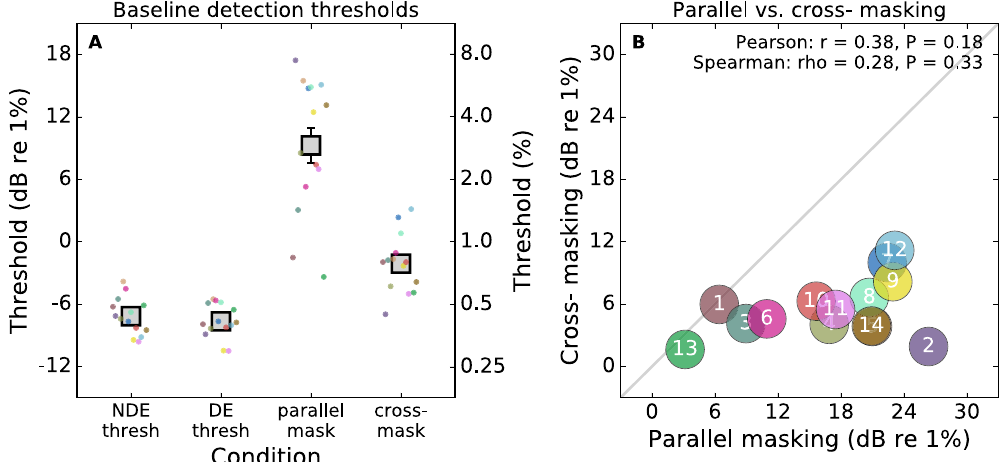
Figure 1. Panel A shows baseline detection thresholds averaged over 14 subjects. Coloured dots show data from individual subjects. Thresholds are given for the non-dominant (NDE) and dominant eyes (DE) without masking. Thresholds are also given for the dominant eye with parallel and cross-oriented 4% contrast masks in the other eye. Error bars show standard error of the mean. Panel B shows the relationship between the parallel and cross-oriented masking measured for each subject. The symbol for Subject 5 is obscured by that for Subject